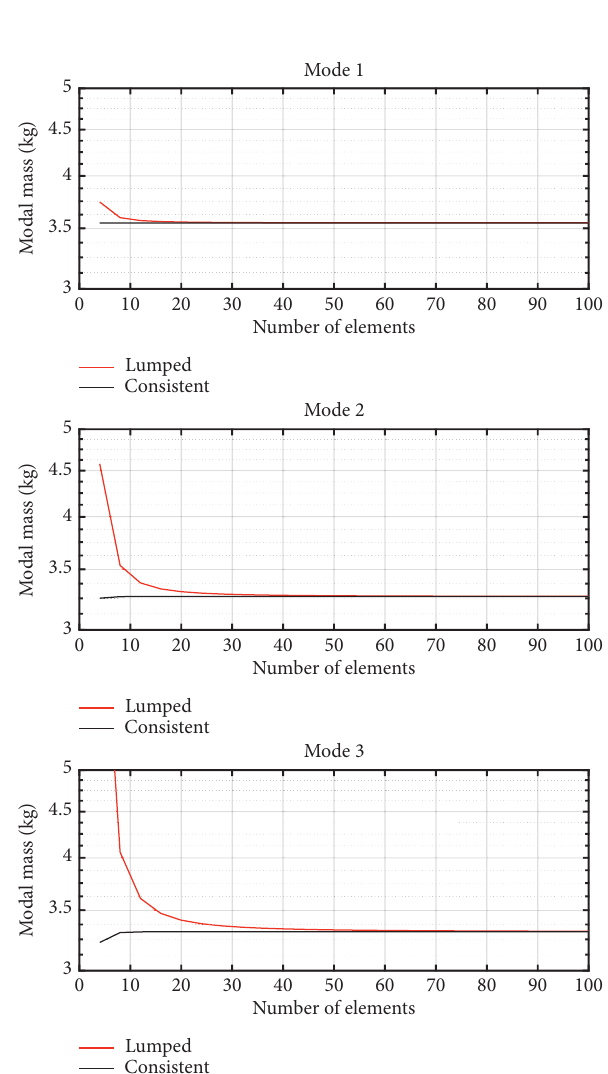
Figure 6: Convergence of the modal masses for the first three modes of the cantilever beam with nonconstant mass